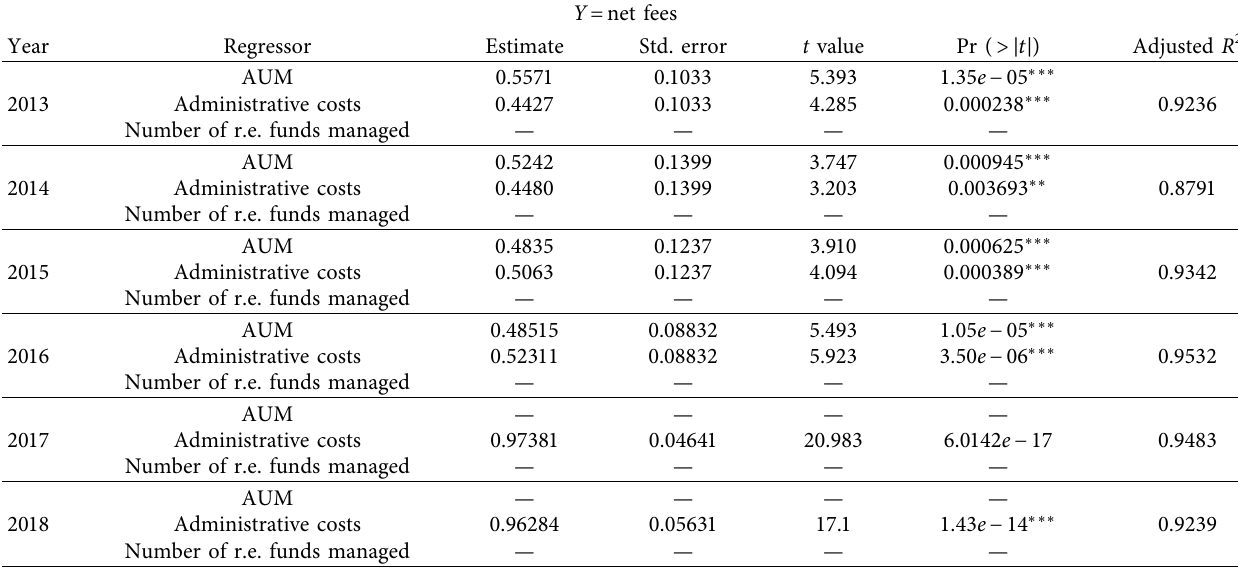
Table 9: Coefficients resulting from the second